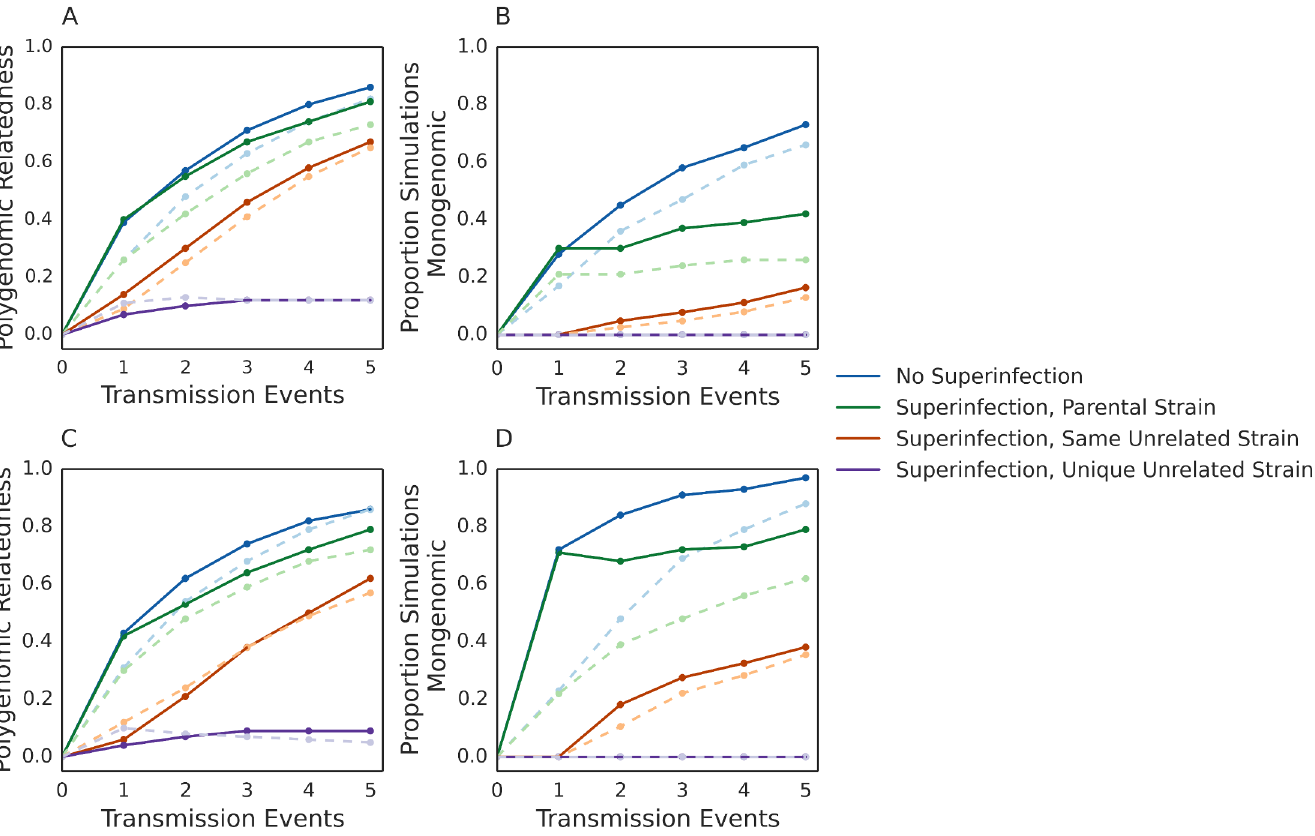
Fig 7. Relatedness of polygenomic infections after multiple transmission events. Line plots of the average relatedness of polygenomic infections (A,C) and proportion of simulations that have converged to the transmission of a single strain after multiple transmission events across 500 simulations (B,D) . Only results from simulations where gametocyte-sampling probabilities are equal (A,B) and where gametocyte sampling probabilities are skewed by a 10:1 ratio between the most frequent and least frequent strain (C,D ) are shown. Blue = No superinfection. Green = Superinfection where the resident strain is the same as one of the parental strains in the initial infection. Red = Superinfection where the resident strain is unrelated to the parental strains in the initial infection. Purple = Superinfection where the resident strain is unrelated and different in each transmission event. Solid dark lines indicate results where the initial polygenomic infection had a COI = 2 and light dotted lines indicate results where the initial polygenomic infection had a COI =